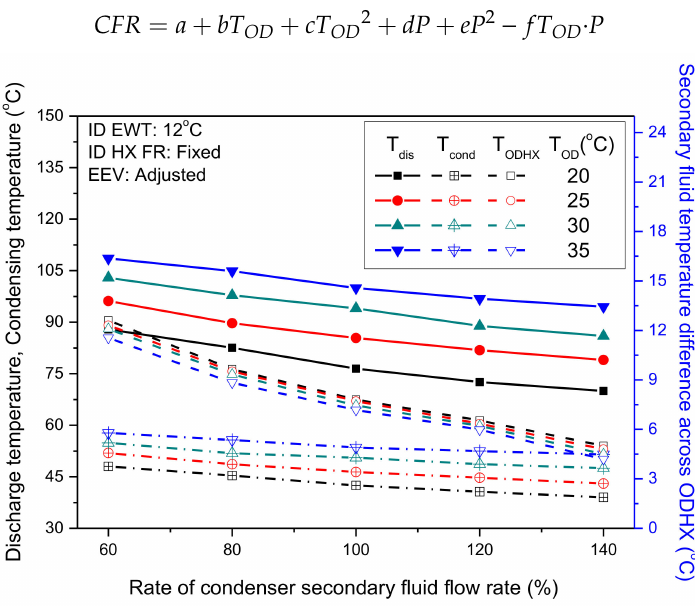
Figure 11. Relationship between condenser SFFR, condensing temperature, and compressor discharge